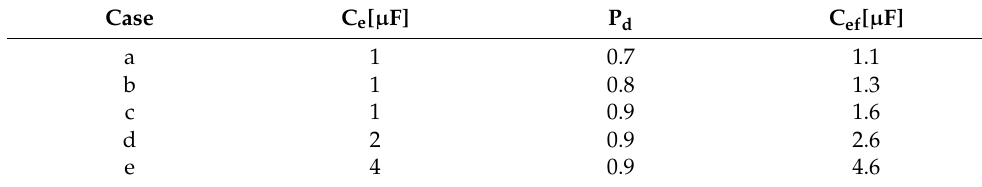
Table 1. Electrical values for the equivalent circuit (Figure 2a) with T s = 0.1 Fs P − 1 , P s =